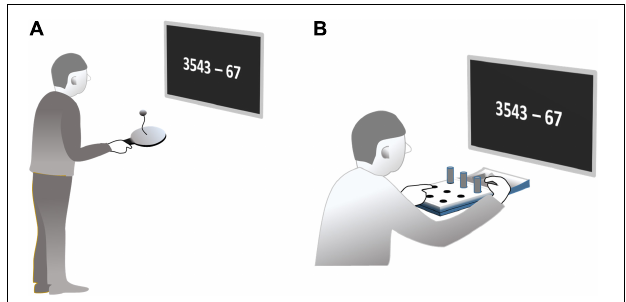
FIGURE 1 | Posture and set-up of the paddleball task (A) and of the pegboard task (B)